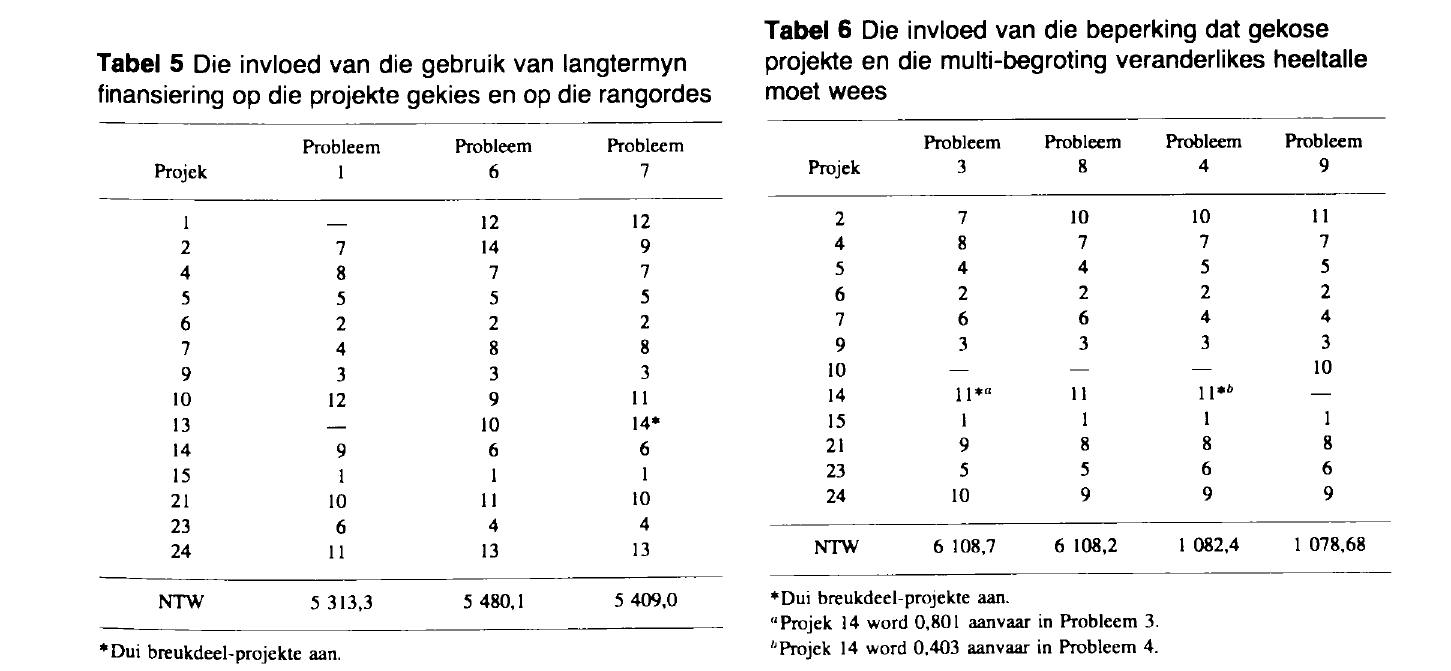
Tabel 5 Die invloed van die gebruik van